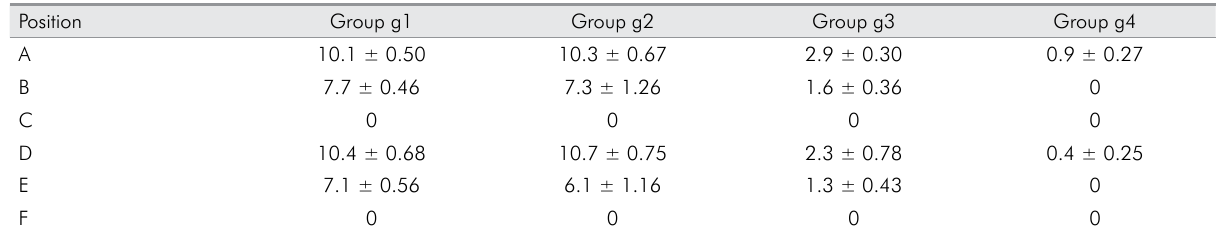
Table 1. Mean misfit values at the determined positions after the application of the four torque levels (expressed in μm).